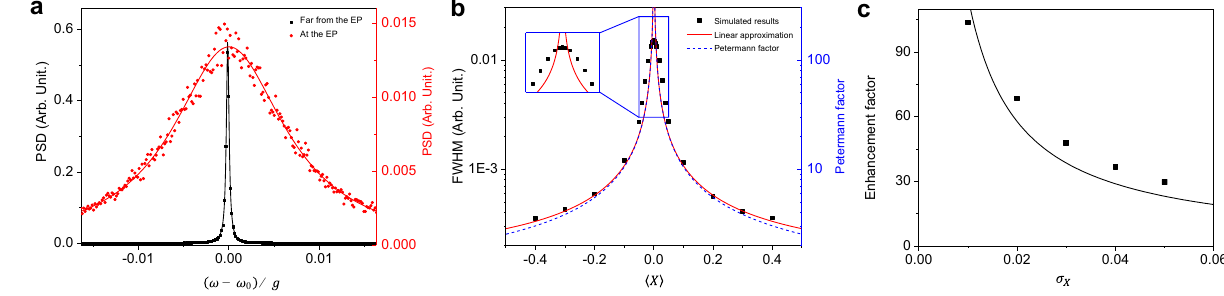
Figure 2. Laser lineshape, linewidth and its enhancement factor. ( a ) Red circles (black squares) represent the power spectral density (PSD) of the laser at the EP (far from the EP, Lorentzian fits. ( b ) Calculated linewidth (full width at half maximum or FWHM) by the analytic theory (red solid curve) under linear approximation and by the numerical simulation (black dots). The standard deviation of the parameter X and the correlation time are assumed as follows: σ X blue dashed curve represents the Petermann factor K . ( c ) The enhancement factor or the ratio of the linewidth at the EP to that far from the EP. The solid black line is a fit in the form of y